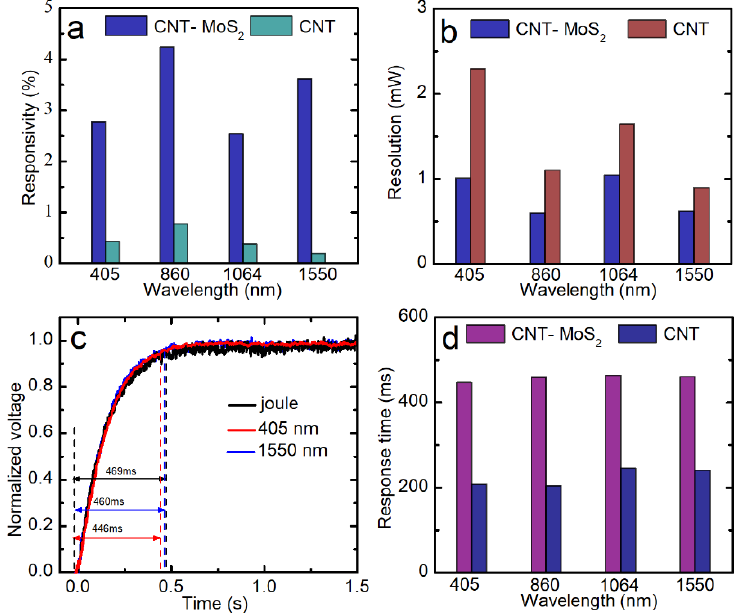
Figure 6. ( a ) A comparison of the reponsivity (d R / R ) values of the unannealed CNT network and the CNT–MoS 2 composite network under the same 2 mW/mm 2 laser power density at different wavelengths. ( b ) A comparison of the sensitivity (the minimum detectable laser power) levels of the unannealed CNT network and the CNT–MoS 2 composite network to different laser wavelengths. ( c ) Comparison of normalized voltage–time profiles between the modulated laser heating and joule heating, showing the same response times and confirming that the photoresponse to the laser is a bolometric effect. ( d ) A comparison of the response times of the unannealed CNT network and the CNT–MoS 2 composite network to different laser